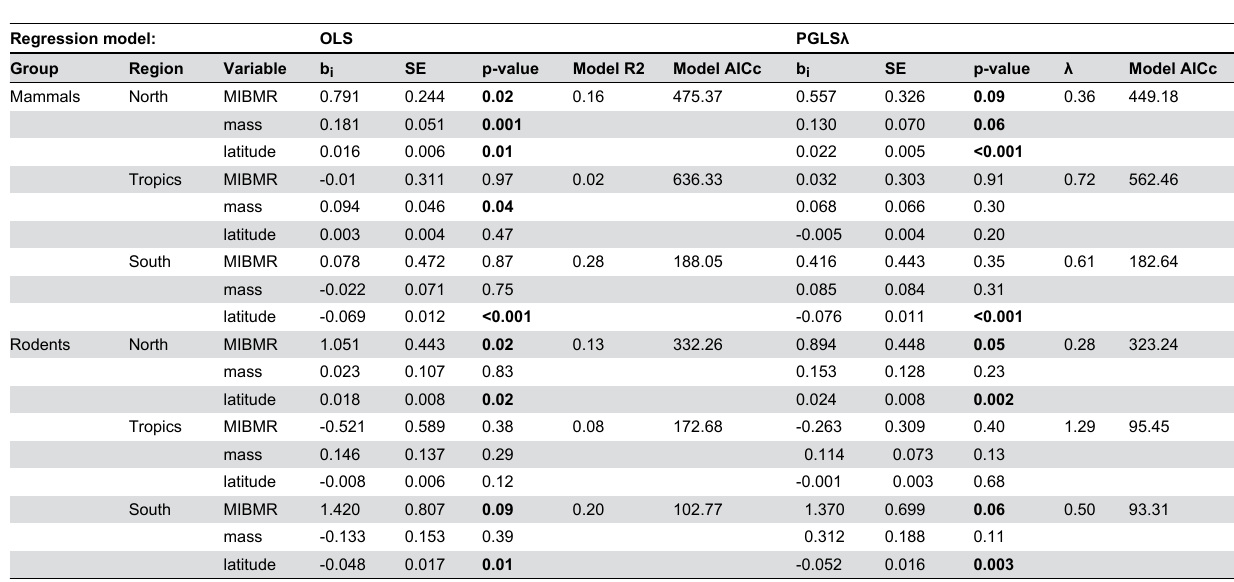
Table 4. Partial regression coefficients (b ) of non-phylogenetic (OLS) and phylogenetic (PGLSλ) multiple regressions of i geographic range size as a function of MIBMR, mass and the range latitudinal midpoint in the North (> 23.7° lat), Tropics (23.7° to -23.7° lat), and South (< -23.7°